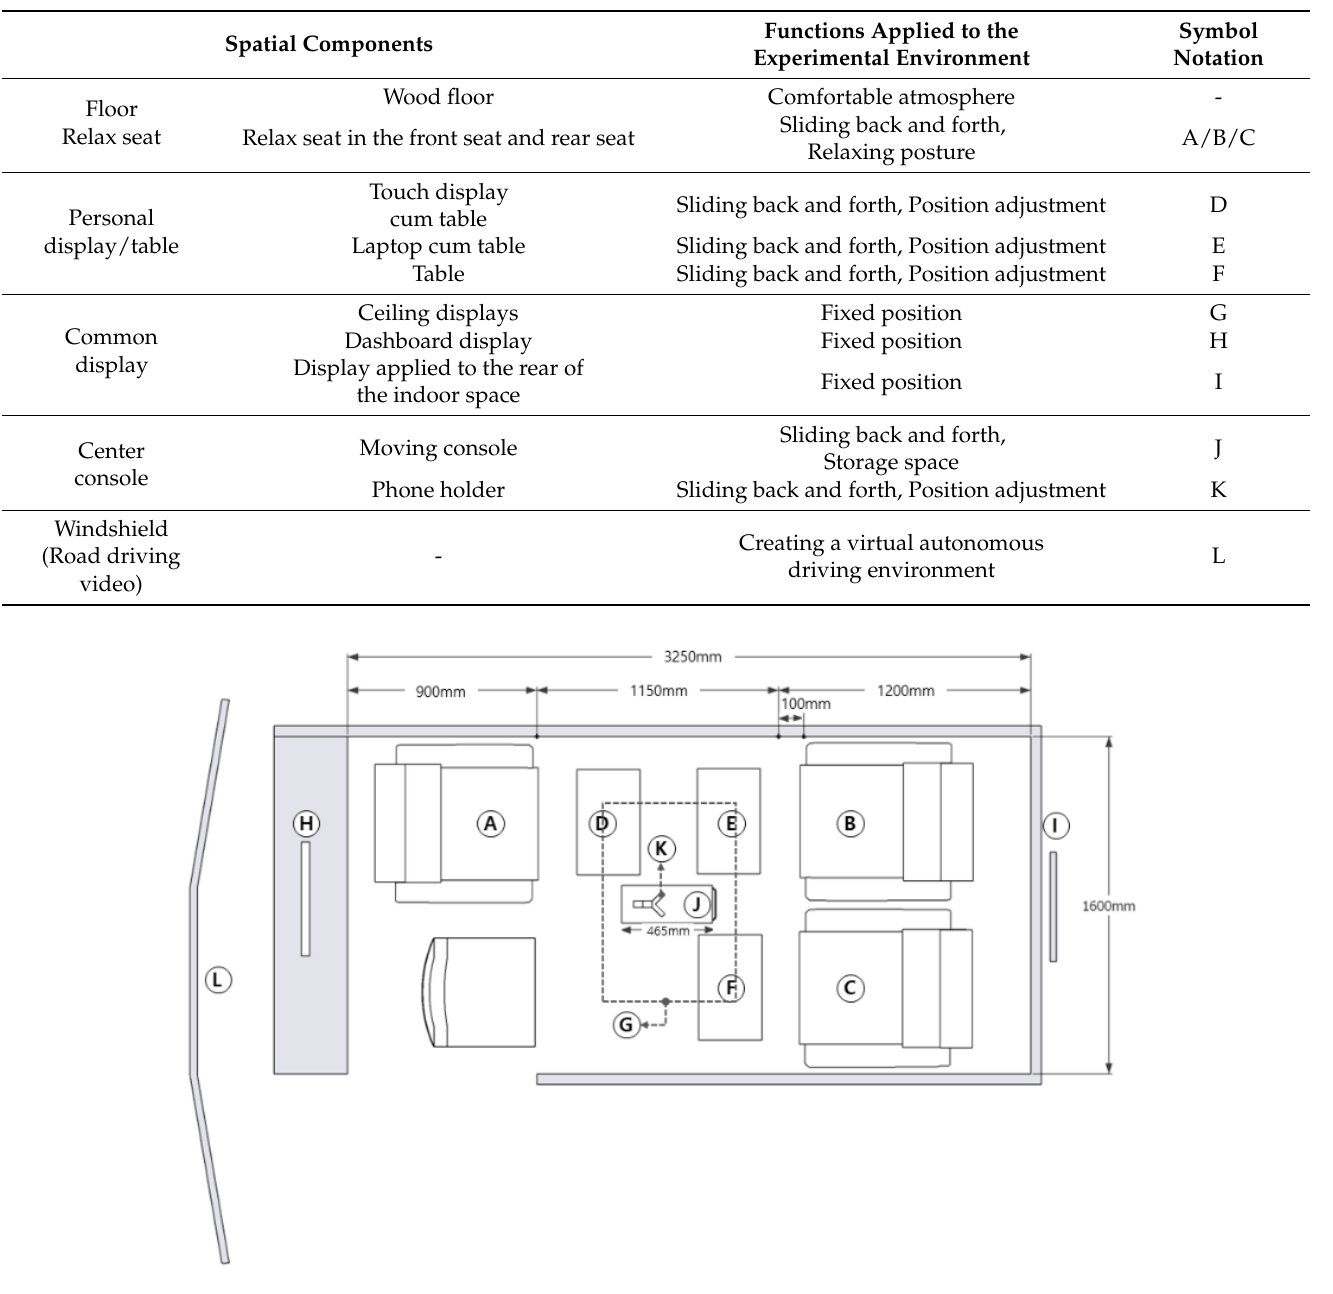
Table 4. Spatial components and experimental environment of fully autonomous vehicles (refer to concept car and consumer studies).